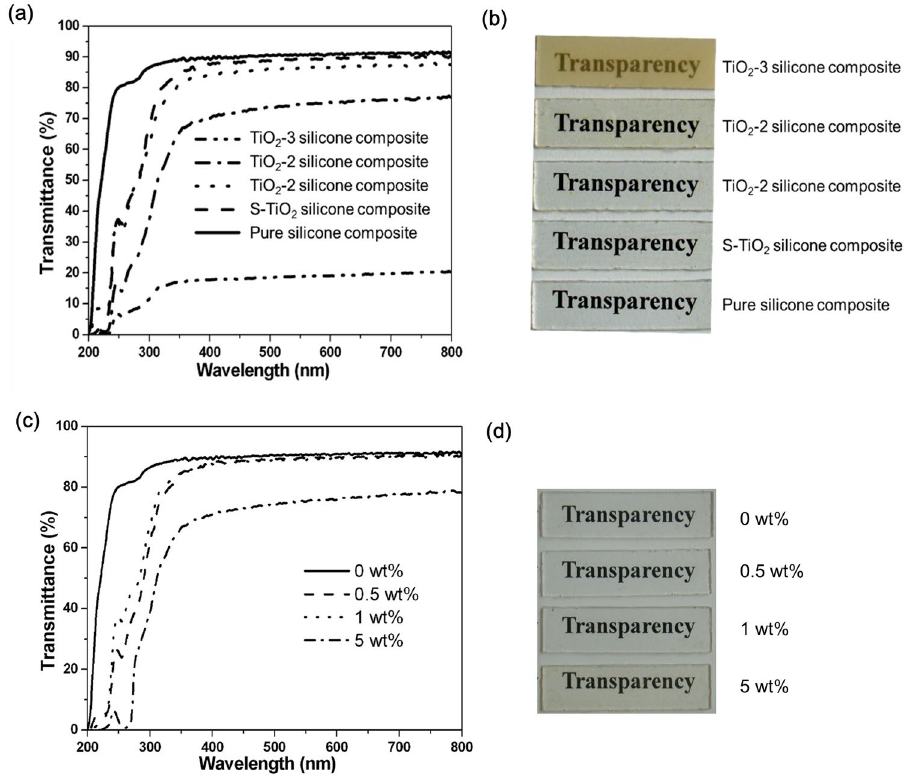
Figure 4. ( a ) Transmittance and ( b ) photograph of the silicone nanocomposite with 1 wt% TiO 2 -3, TiO 2 -2, TiO 2 -1 and S-TiO 2 , and pure silicone as the control; ( c ) transmittance and ( d ) corresponding photograph of titanate S-TiO 2 /silicone nanocomposites with varied S-TiO 2 mass